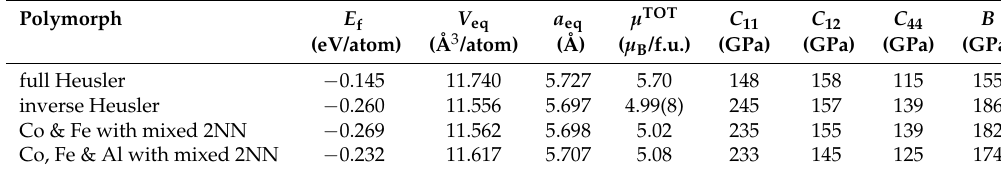
Table 1. Calculated thermodynamic, structural, magnetic and elastic parameters of the studied Fe 2 AlCo polymorphs. Listed are values of the formation energy E f , equilibrium volume per atom V eq , equilibrium lattice parameter a eq of 16-atom supercells shown in Figure 1, magnetic moments µ TOT per formula unit (f.u.), and single-crystal elastic stiffnesses C 11 , C 12 and C 44 together with the bulk moduli B derived from these elastic stiffnesses ( B = ( C 11 + 2 C 12 )/3). Polymorph E f V eq a eq µ TOT